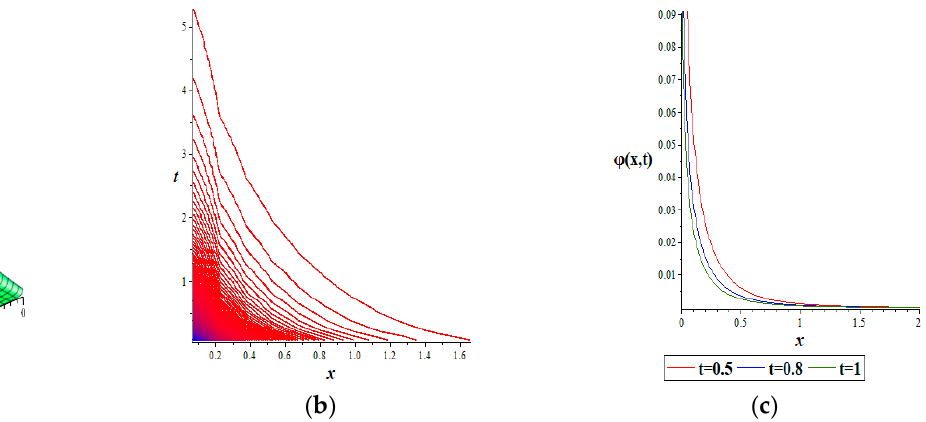
ϕ of Equation (54) for values = t , and 1,8.0,5.0 for 2D graph.